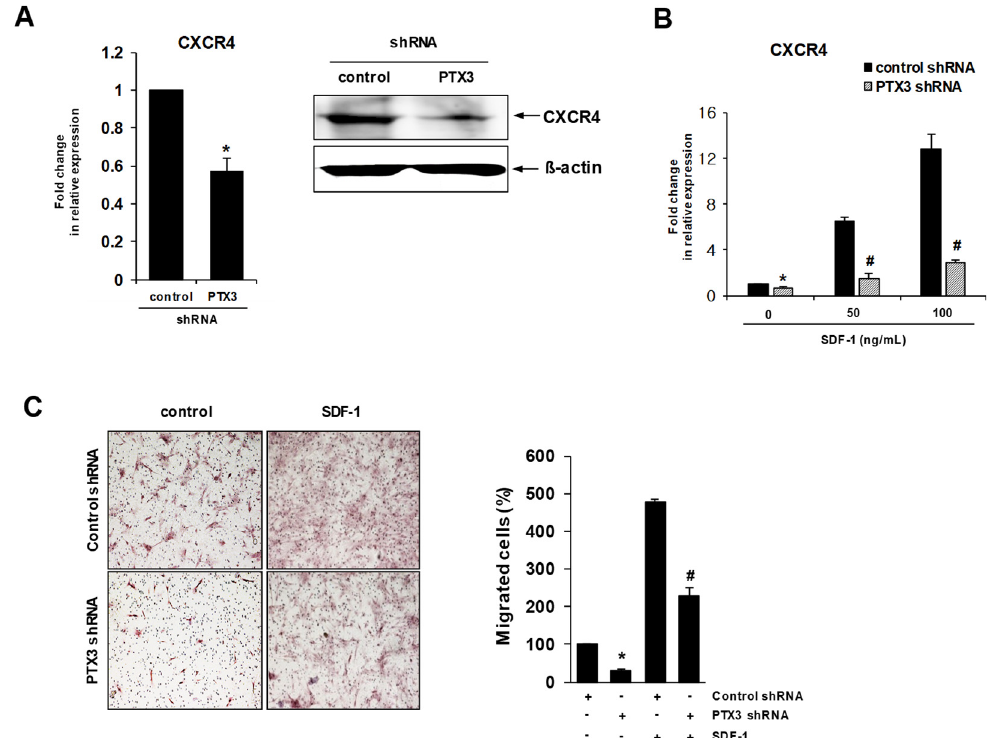
Figure 4. Effect of PTX3 knockdown on SDF-1 α /CXCR4 axis in human dental pulp stem cells. ( A